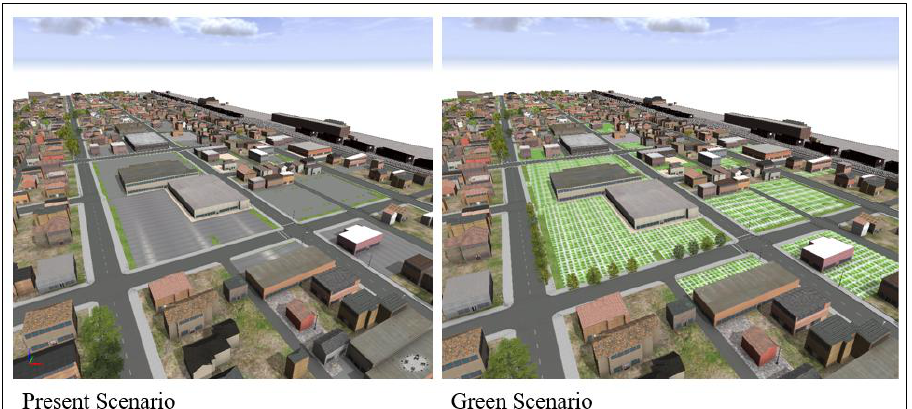
Figure 11. Visualization at a block scale for present and proposed scenarios in CityEngine.